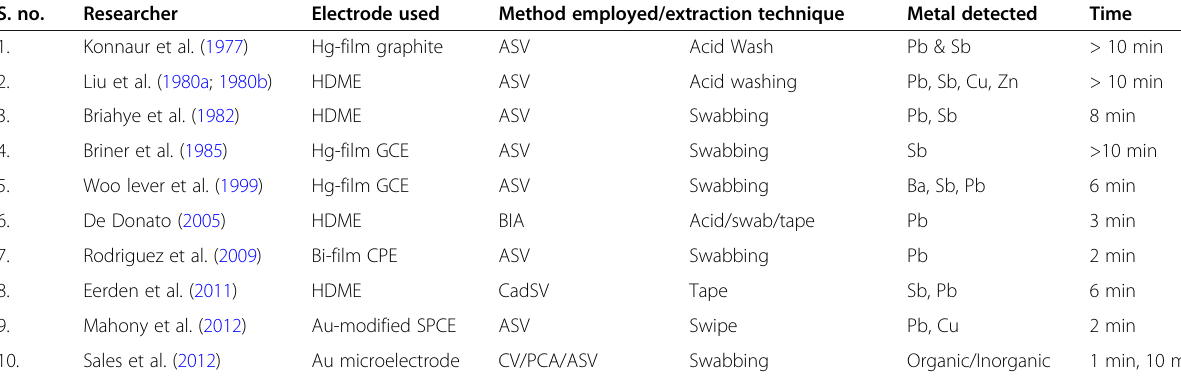
Table 5 Electrode-based protocol developed to detect gunshot residue S.